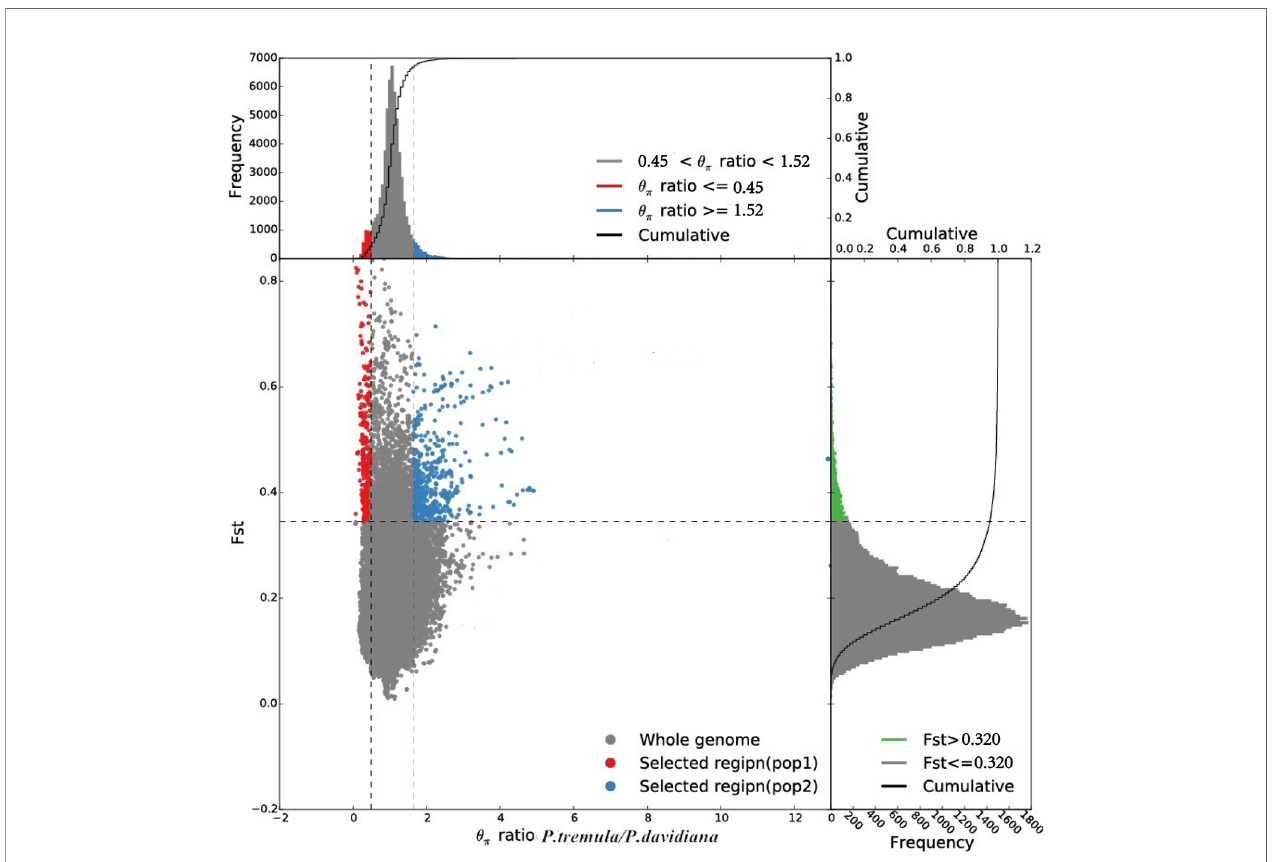
FIGURE 6 | Distribution of qp ratios ( P. tremula / P. davidiana ) and F ST values, which are calculated in 100 kb windows sliding in 10 kb steps. Data points located to the left and right of the left and right vertical dashed lines, respectively (corresponding to the 5% left and right tails of the empirical qp ratio distribution), and above the horizontal dashed line (the 5% right tail of the empirical F ST distribution) were identi fi ed as selected regions for the P. tremula (red points) and P. davidiana (blue points) populations.